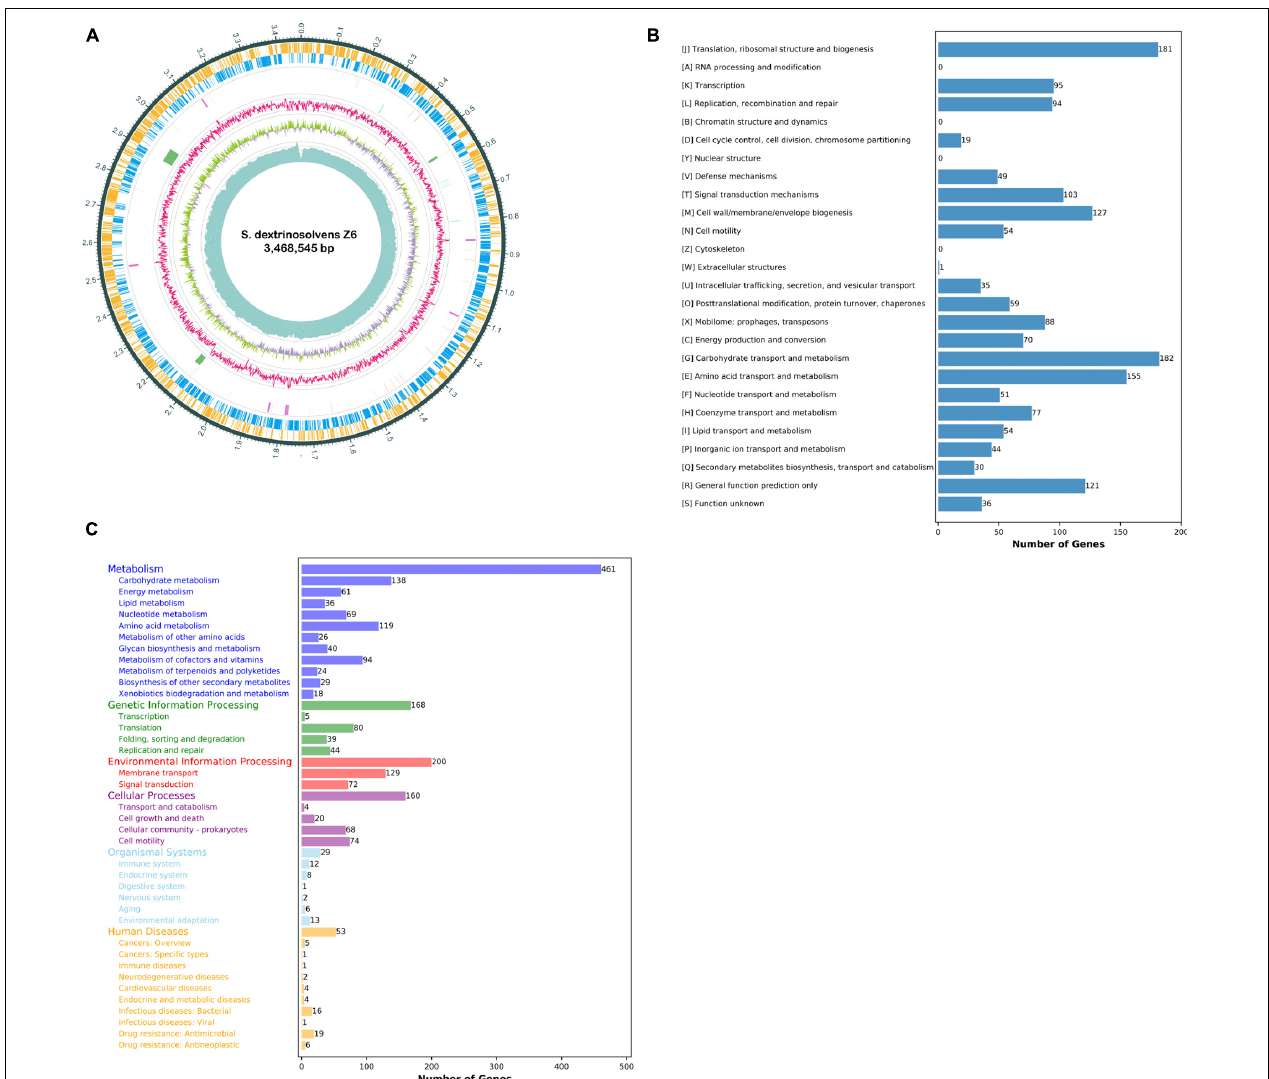
FIGURE 1 | Succinivibrio dextrinosolvens strain Z6 genome information. (A) Circle diagram showing the nuclear genome. From the outside to the inside are the coding genes (sense), coding genes (antisense), tRNAs (orange) and rRNAs (purple), CRISPRs (blue) and gene islands (green), GC ratio, GC-skew, and sequencing depth. (B) Functional classification of genomically encoded proteins in clusters of orthologous groups (COG). (C) Functional classification of genomically encoded proteins using the Kyoto Encyclopedia of Genes and Genomes (KEGG)